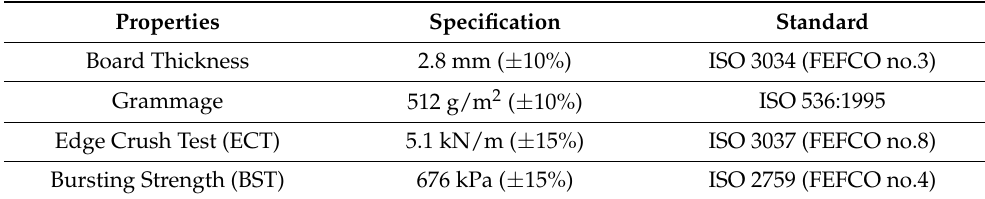
Table 1. Material properties of the B-flute corrugated